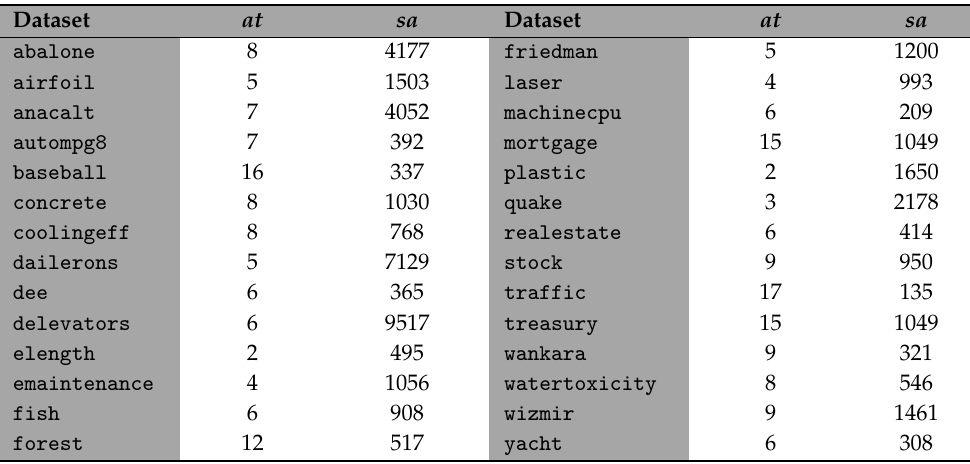
Table 1. Regression datasets employed in the